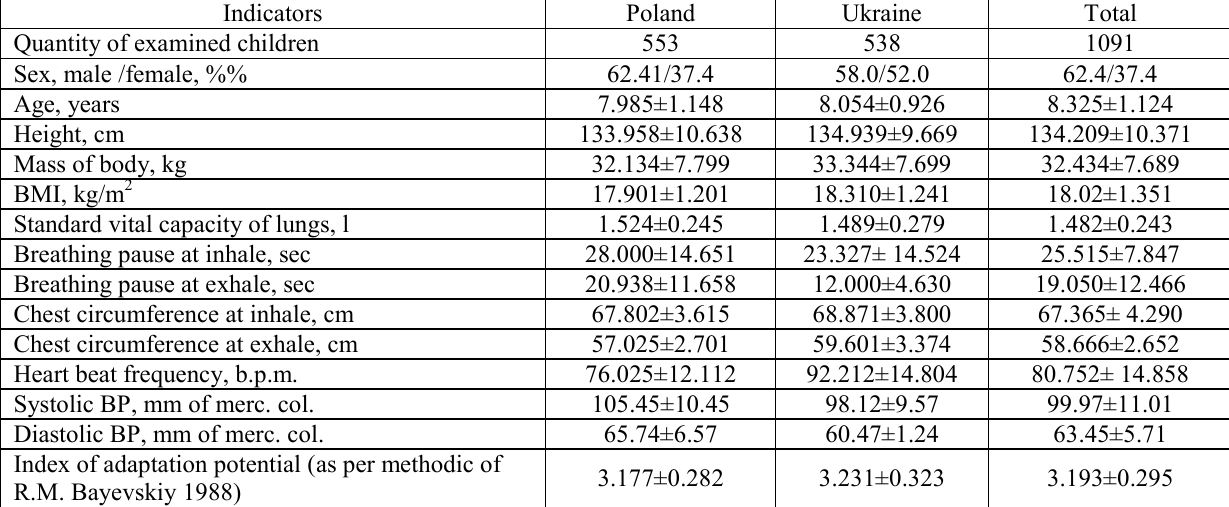
Passport data and functional state of cardio-vascular and respiratory systems of the examined children Indicators Poland Ukraine